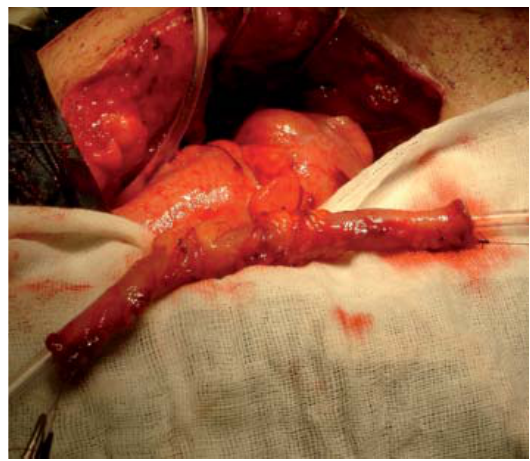
Figure 3 - Tubularization of the incised ileal segments. Figure 5 - Reapproximation of detrusor layer to create a submucosal tunnel.